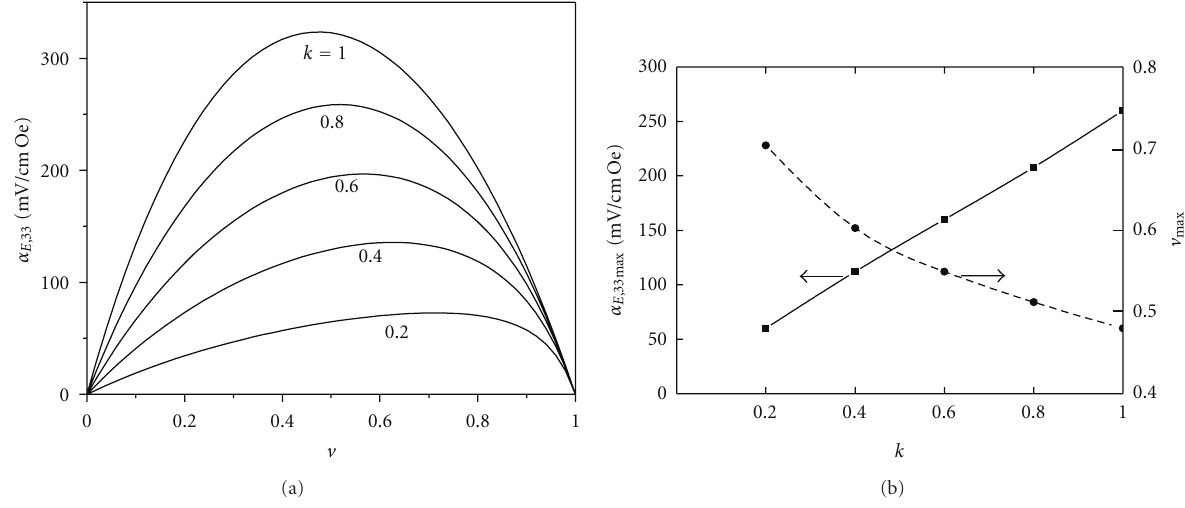
Figure 3: (a) Estimated dependence of longitudinal ME voltage coe ffi cient on interface coupling k and volume fraction v for symmetric structure of CFO and PZT. (b) Variation with k of maximum α E ,33 and the corresponding v max .